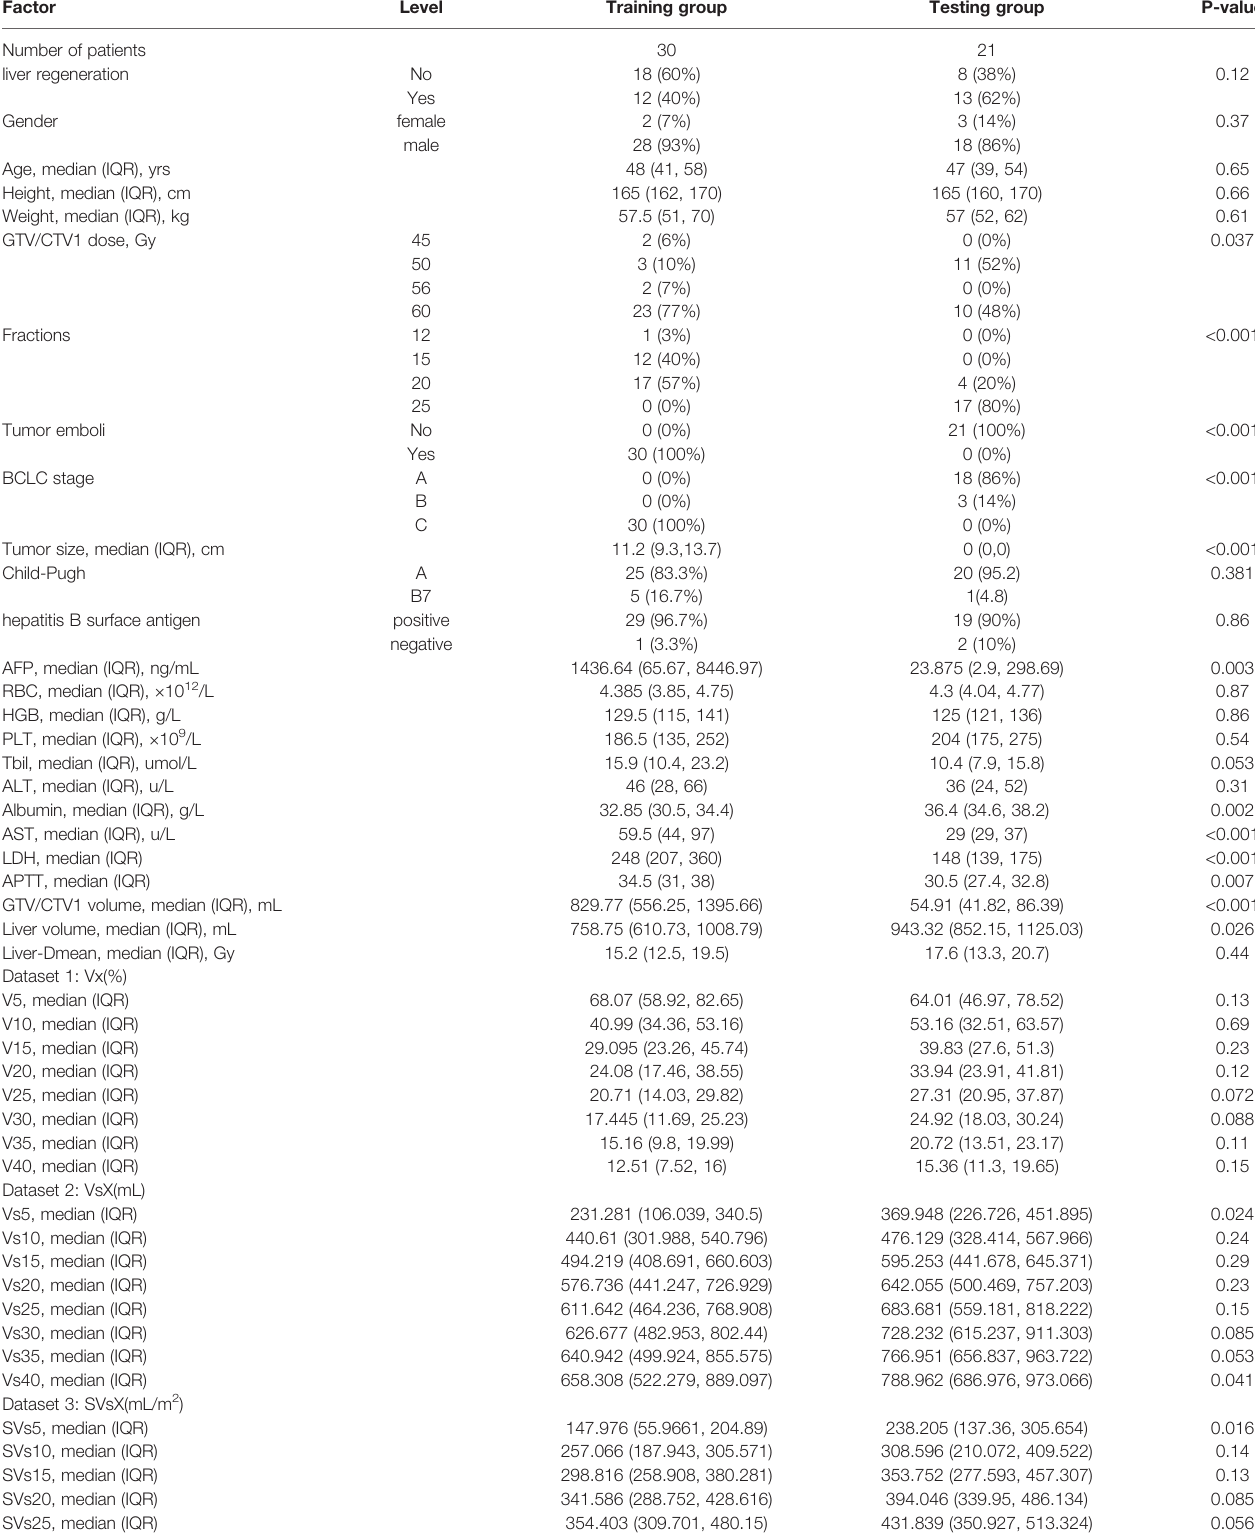
TABLE 1 | Information of patients in different treatment